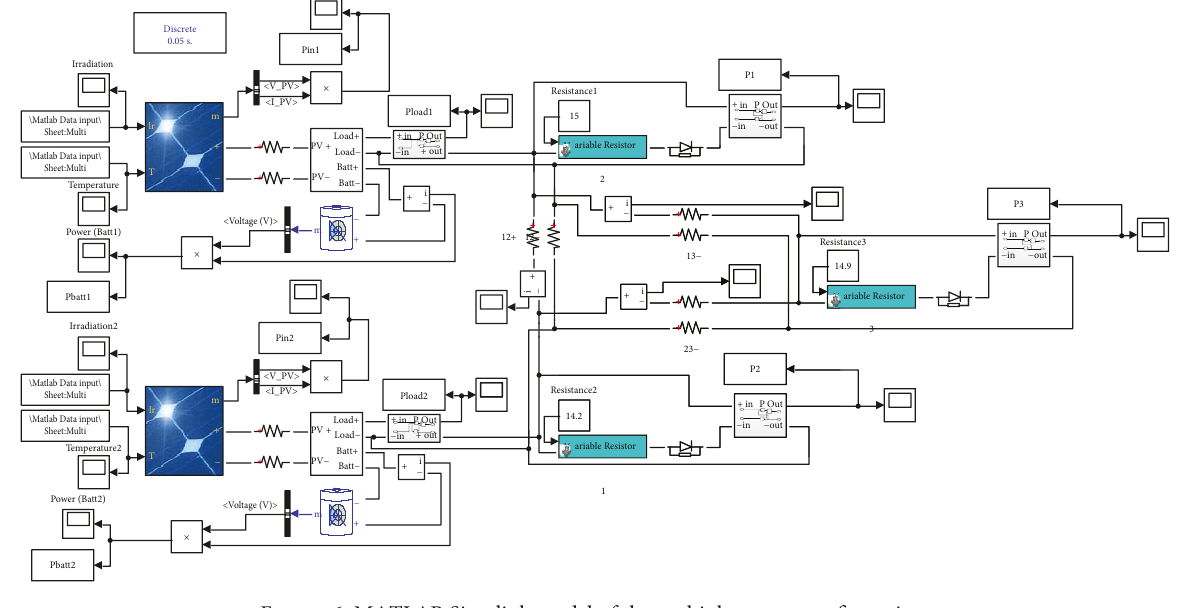
Figure 6: MATLAB Simulink model of the multiple-source con fi guration.